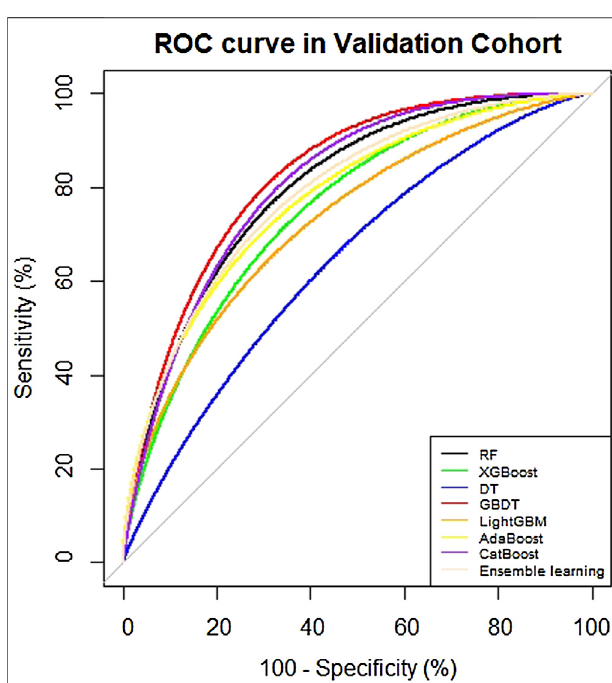
FIGURE 5 | ROC curve of eight models in the test